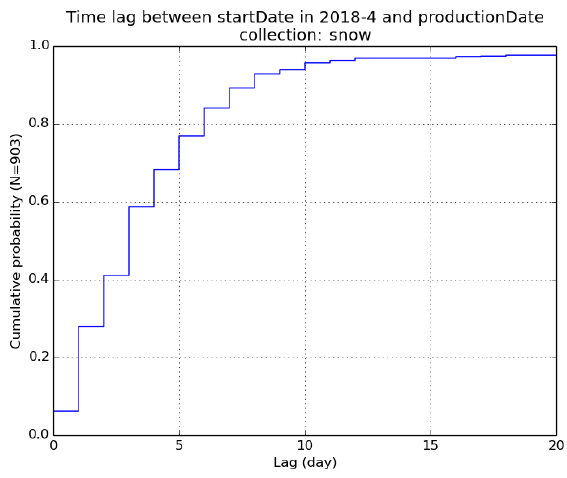
Figure 6. Cumulative probability of the time lags between the Sentinel-2 acquisition and the distribution date of the correspond- ing snow product, computed for all snow products with acquisition date in April 2018.